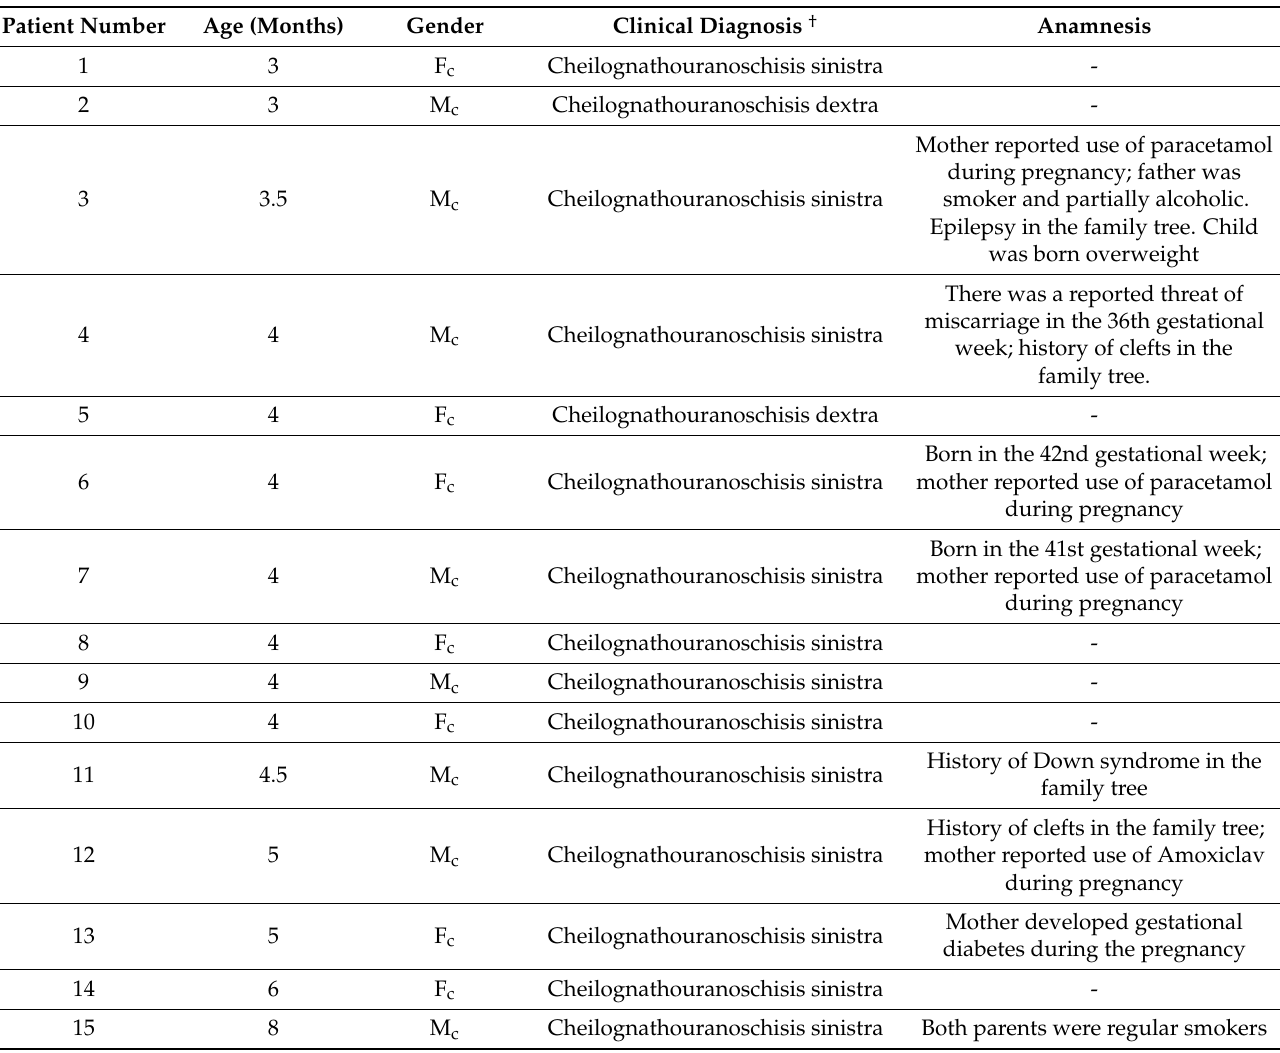
Table 2. Clinical diagnosis and demographic profile of the cleft affected